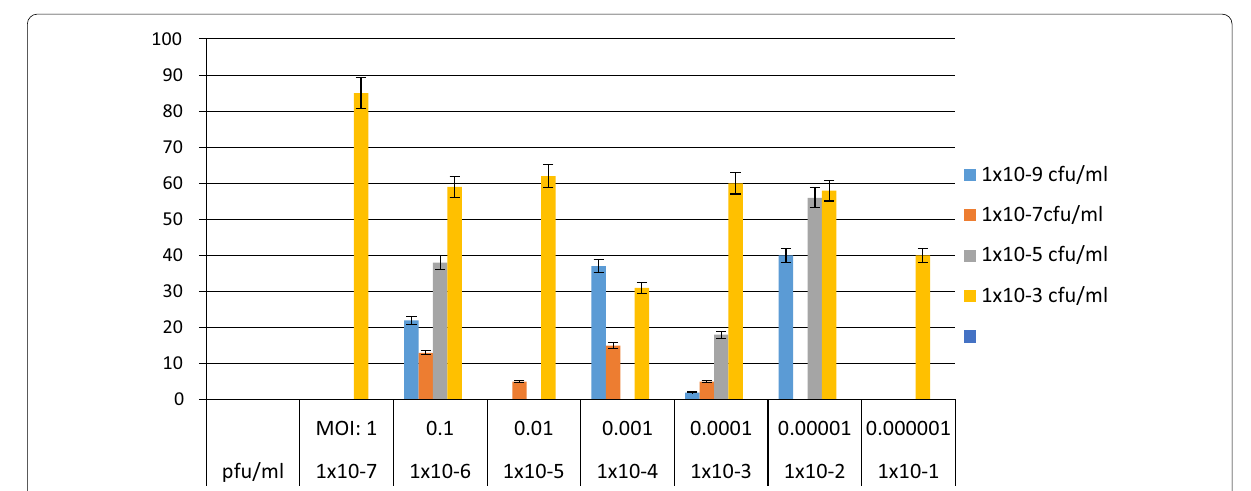
Fig. 7 Lysis effect of ɸ ParuNE1 on P. aeruginosa CLI